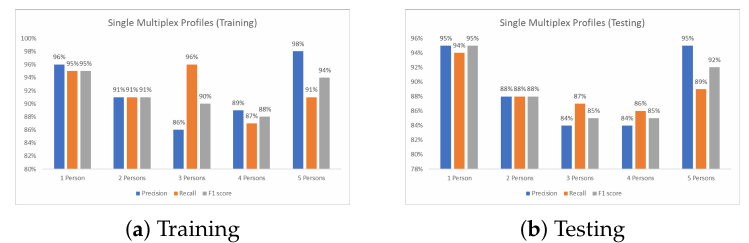
Figure 23. TAWSEEM: precision, recall, and F1 score (single multiplex profiles).